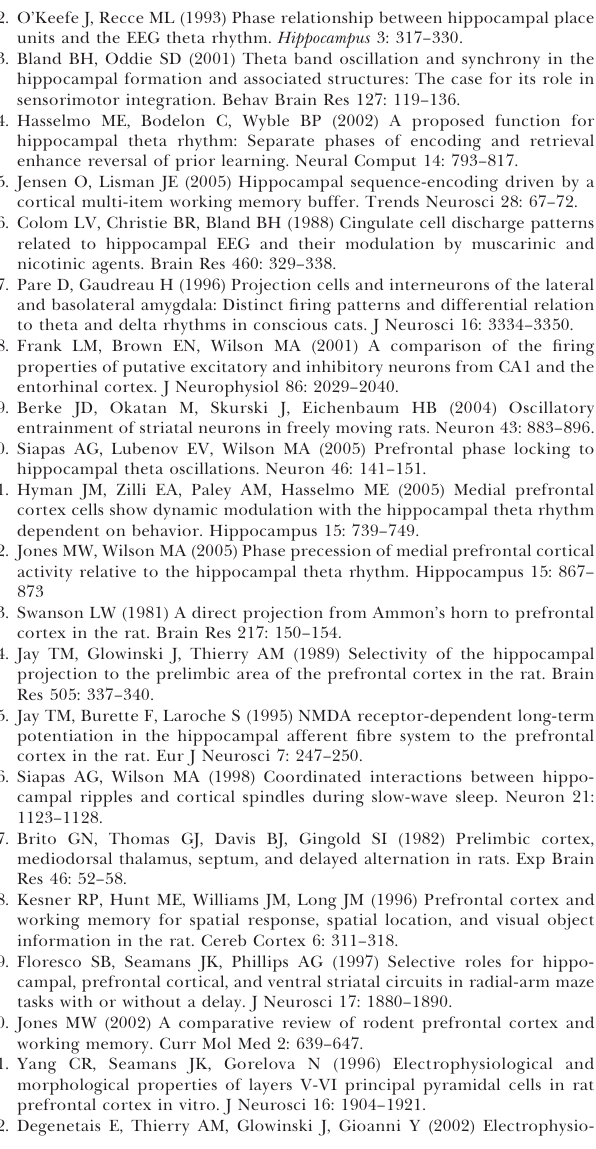
Figure S1. Details of Movement Trajectories and Running Speed (A) Raw data showing positional samples (taken from LEDs mounted on the rat’s head, 30-Hz sampling rate) during a single run-session. Blue box marks the central three-quarters section of the central arm used throughout analyses comparing choice and forced-turn direc- tions. Scale bar 6 cm. (B) Mean central-arm trajectories averaged across all rats and trials for the different behavioral epochs ( 6 1 standard deviation marked by the width of the shaded area). Upper panel compares choice- correct runs (solid red line and dark red shading) with choice-error runs (dashed red line and lighter shading). Lower panel compares choice-correct with forced-turn runs (grey line and shading). Trajectories show considerable overlap on this section of the maze; systematic variations in trajectory are therefore unlikely to explain the enhanced coordination seen during choice-direction runs. (C) Mean running speeds across the central arm (same color scheme as in [B]). Found at DOI: 10.1371/journal.pbio.0030402.sg001 (2.8 MB PDF). Figure S2. Raster Plots Illustrating Trial-By-Trial Firing on the Central Arm of the Maze for the Three Neurons Shown in Figure 2 A CA1 pyramidal cell is shown in (A), while (B) and (C) show